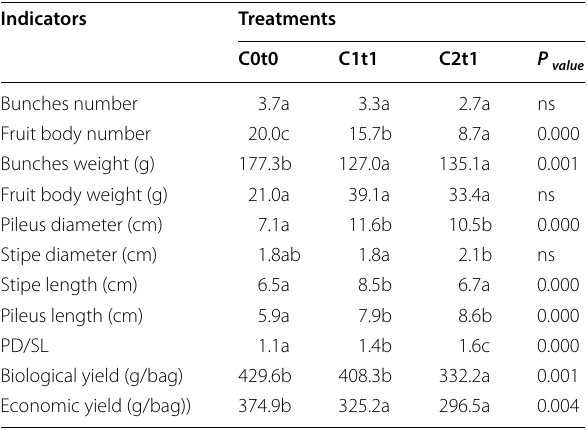
Values are means; means within the same row followed by the same letters are not significantly different at P < 0.05 according to Duncan’s multiple range